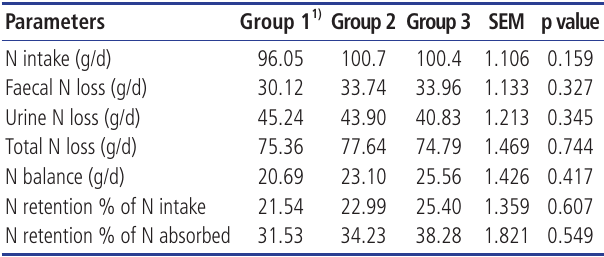
Table 4. Effect of feeding blend of essential oils (BEO) on nitrogen intake and balance during metabolism trial in growing buffalo